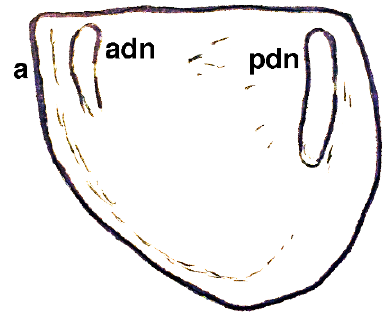
Figure 7. Beyrichona tinea . Anterior to left. Length of shield 3.2 mm. Abbreviations: a, anterodorsal cardinal marginal concavity; adn , anterodorsal node; pdn , posterodorsal node. Image Credit: Mark McMenamin.